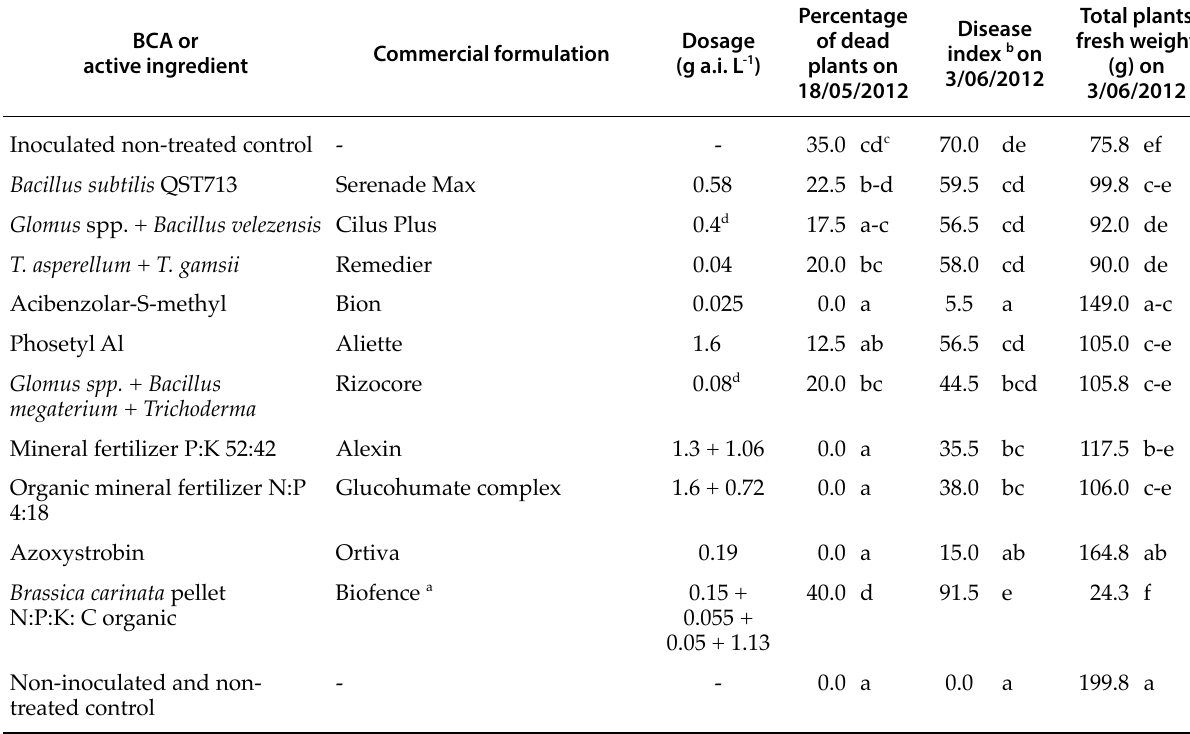
Table 4. Trial 2. Mean proportions of dead plants, mean disease indices (0-100) and mean total plant fresh weights, for tomato plants receiving different